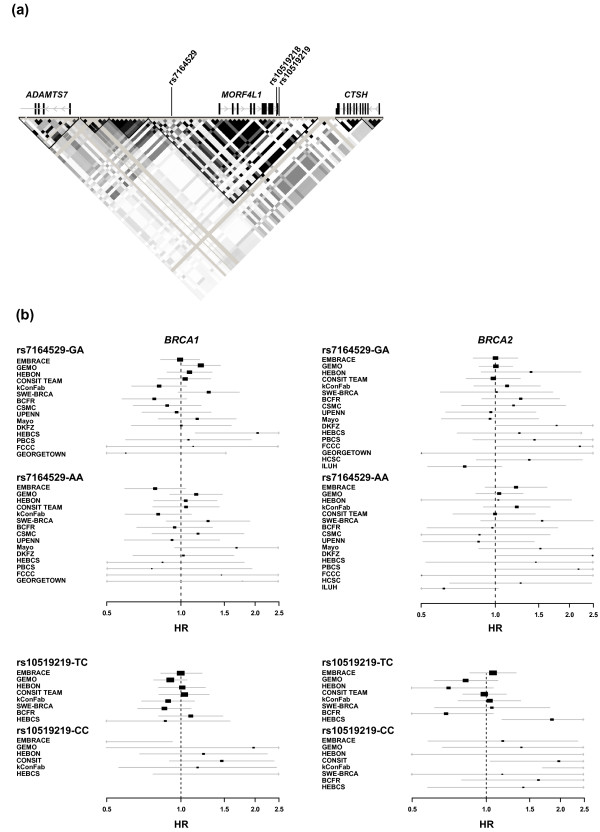
Variation at the MORF4L1 locus and breast cancer risk. (a) SNPs with previous suggestive evidence of association with breast cancer (BrCa) risk in the general population (P2df < 0.01) [67], genes and the linkage disequilibrium structure around MORF4L1 in HapMap Caucasians (data release 27). (b) Hazard ratio (HR) estimates of association of rs7164529 (top panels) and rs10519219 (bottom panels) with BrCa risk among BRCA1 (left panels) and BRCA2 (right panels) mutation carriers. Graphs show HRs and 95% confidence intervals of heterozygotes and minor allele homozygotes for all participating centers except for rs10519219 and relatively small groups (less than five individuals with the minor genotype). Size of the rectangle is proportional to the corresponding study precision.